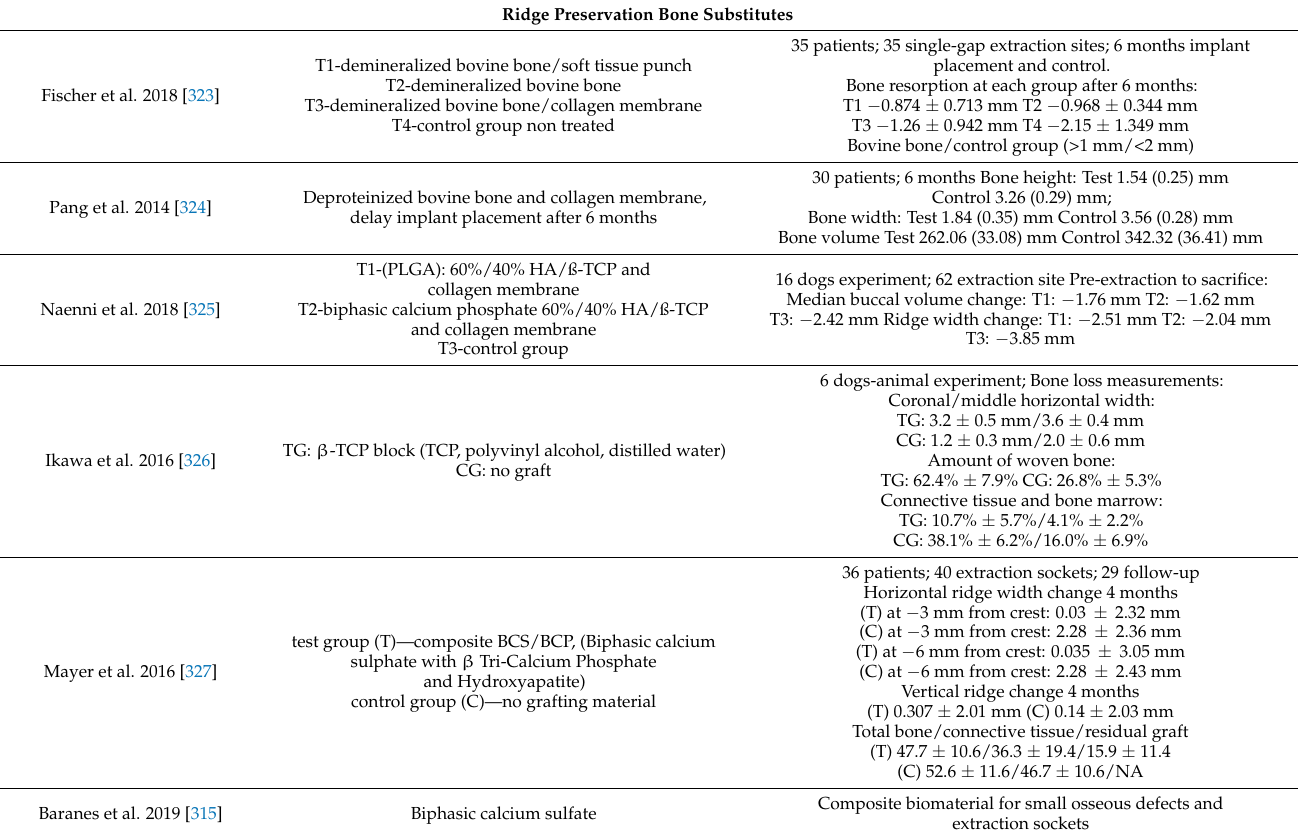
Table 4. Cont. Ridge Preservation Bone Substitutes 35 patients; 35 single-gap extraction sites; 6 months implant T1-demineralized bovine bone/soft tissue punch placement and control. T2-demineralized bovine bone T3-demineralized bovine bone/collagen membrane T4-control group non treated Deproteinized bovine bone and collagen membrane, delay implant placement after 6